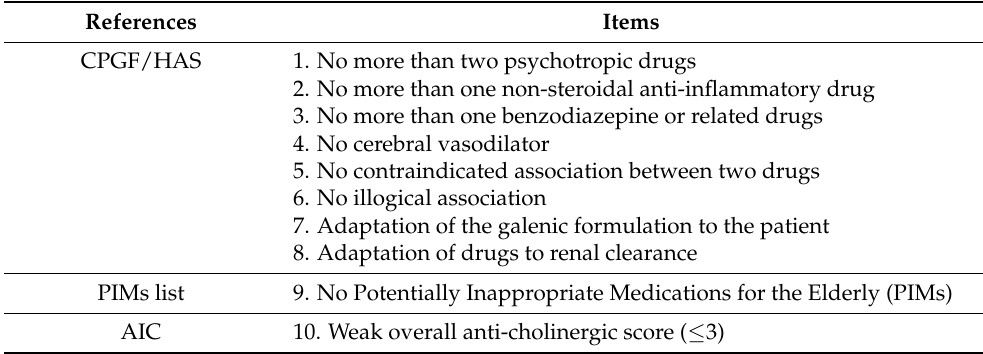
Table 1. Items selected for the evaluation grid of the clinical audit focused on prescriptions in the elderly person in medical